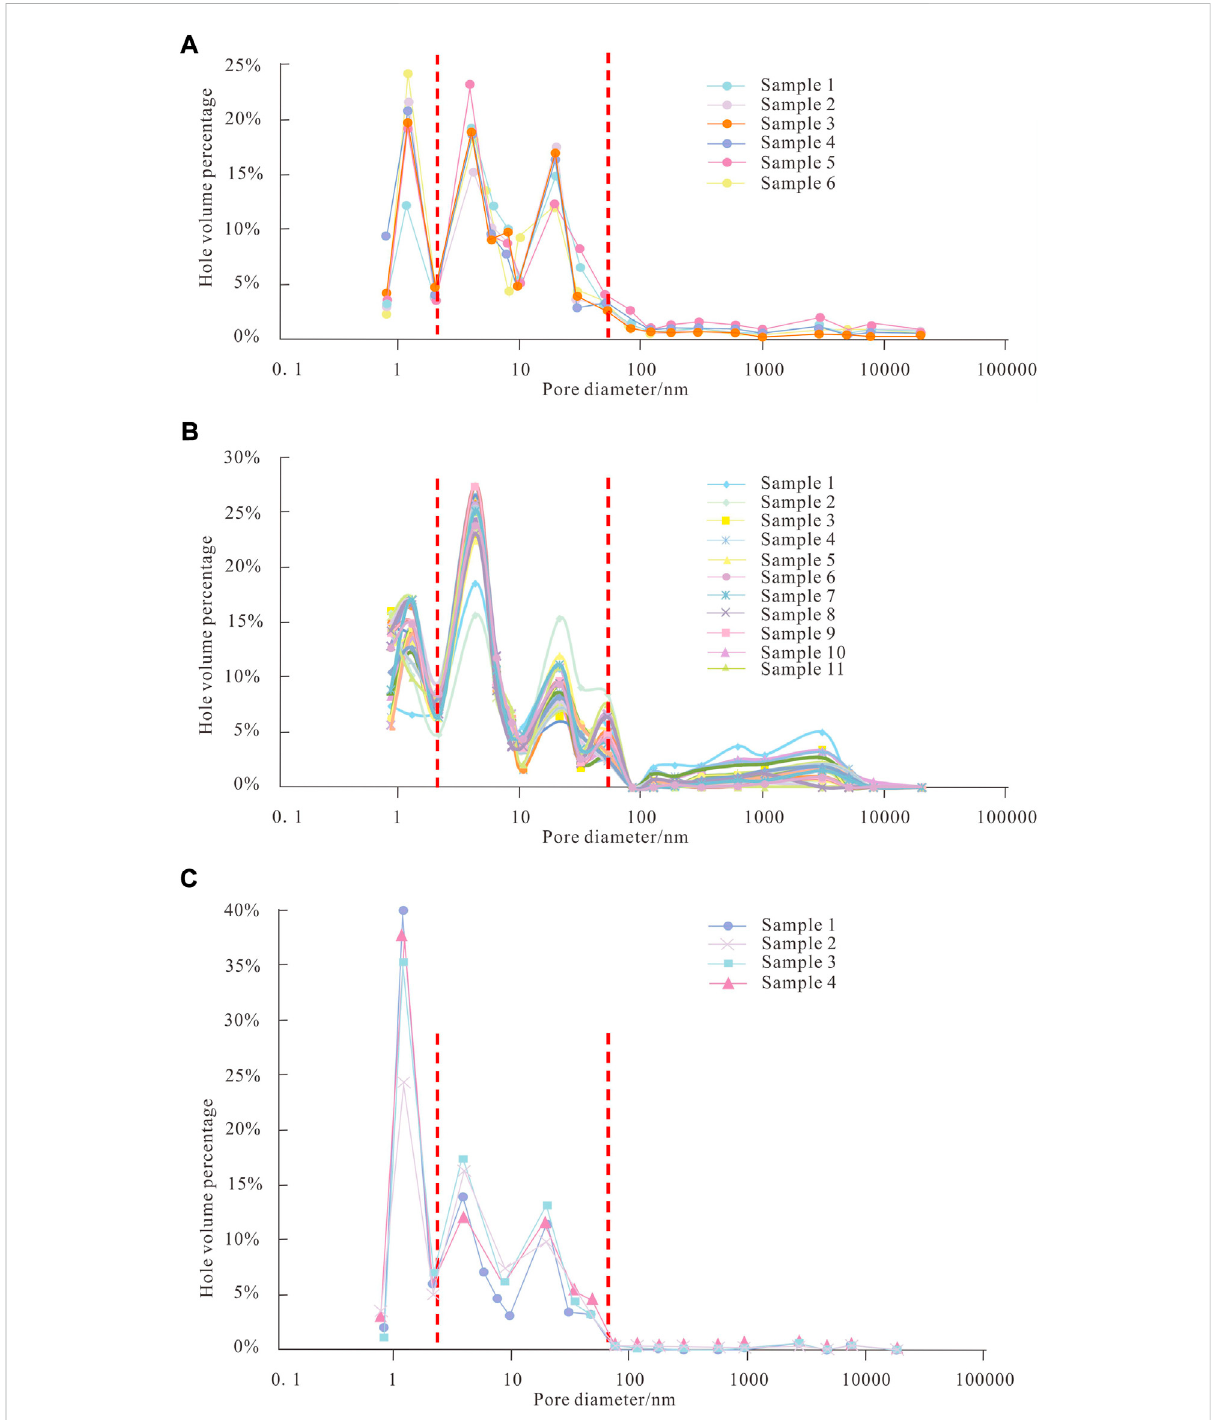
FIGURE 11 Comparison ofporesize distributionof tuffaceous rocksand shale inthesichuan basin (A) Pore sizedistribution oftuffaceousrock inwujiaping formation; (B) Pore size distribution of shale in longmaxi formation; (C) Pore size distribution of shale in dalong